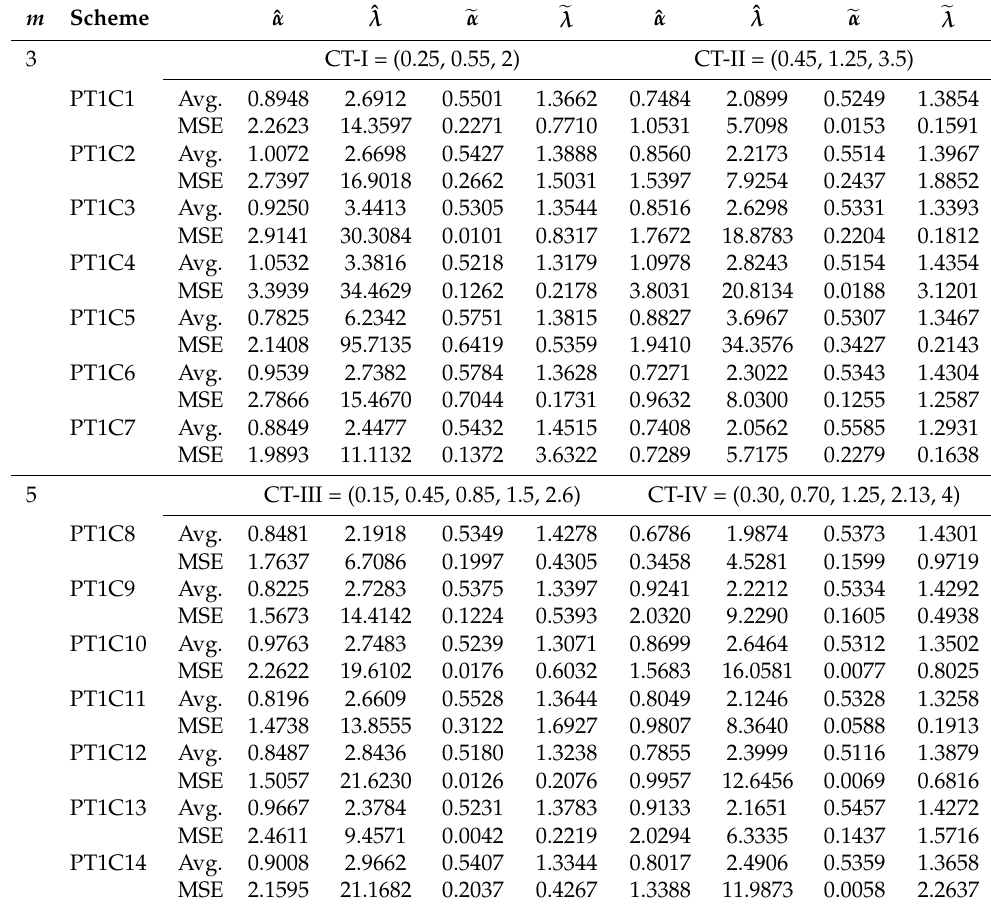
Table 2. Average estimated values and MSErs of the ML and BEs for NH model with α = 0.5 and λ = 1.5 under various censoring schemes at n = 25.